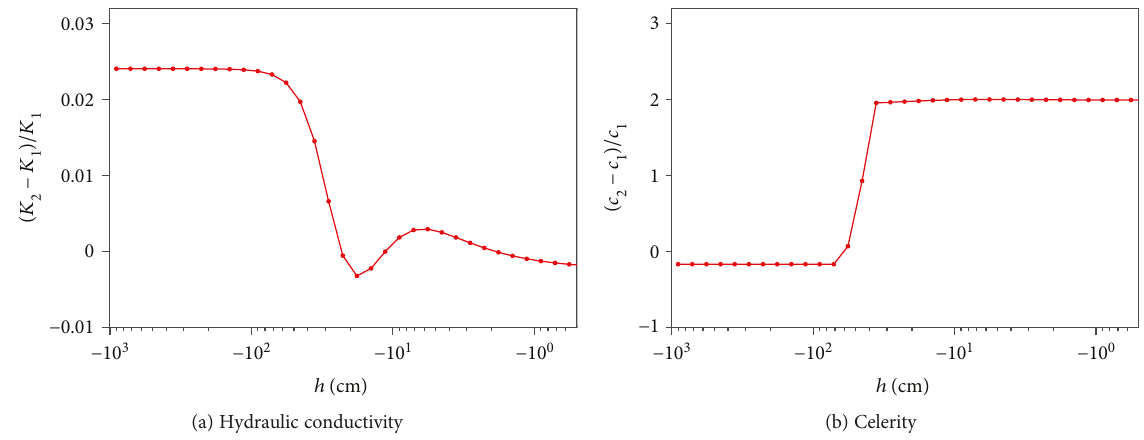
Figure 8: Relative di ff erence of (a) unsaturated hydraulic conductivity and (b) celerity of total soils under the two parameter sets of Table